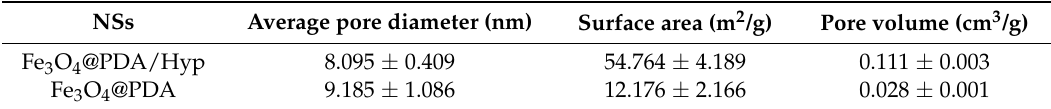
Table 2. The pore size, surface area, and the pore volume of the NSs.